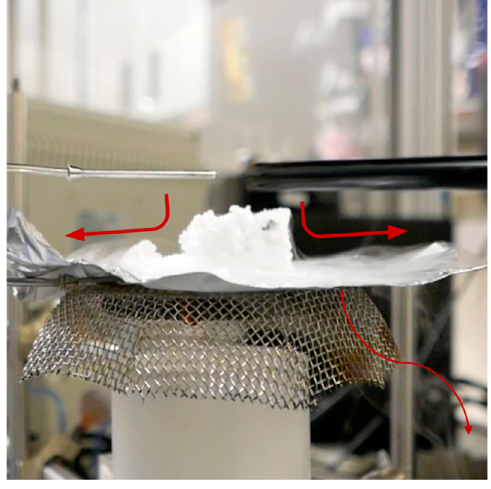
Figure 3. The methane hydrate warming up at room temperature. The arrows show the clear pathway of the cold gas flowing along the foil surface and moving downward. These flows were confirmed with both visual and schlieren imaging.